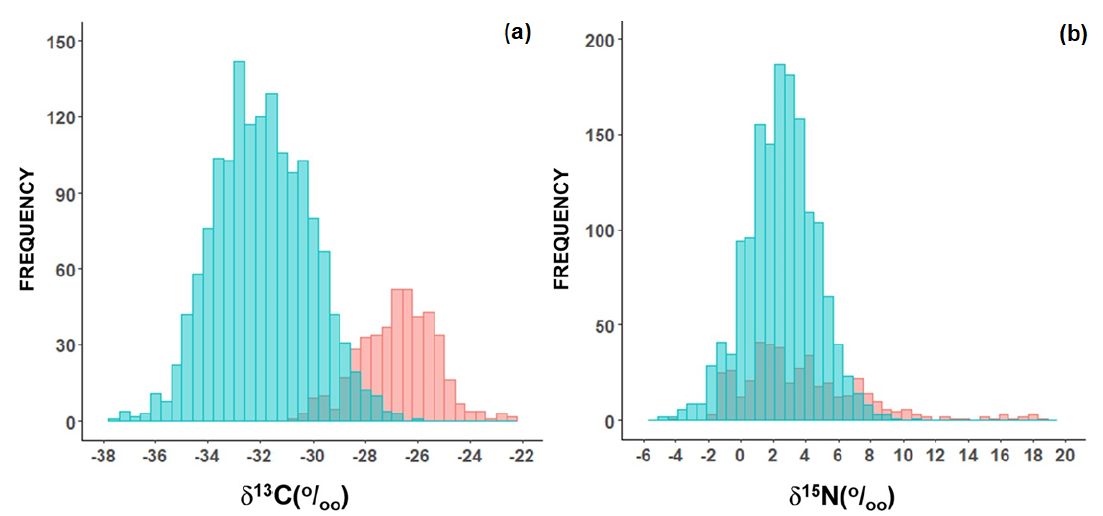
Figure 6. Frequency histogram of δ 13 C ( a ) and δ 15 N ( b ) comparing native tree leaves of the Atlantic Forest (blue bars) with domesticated plants used as food in Brazil (red bars).